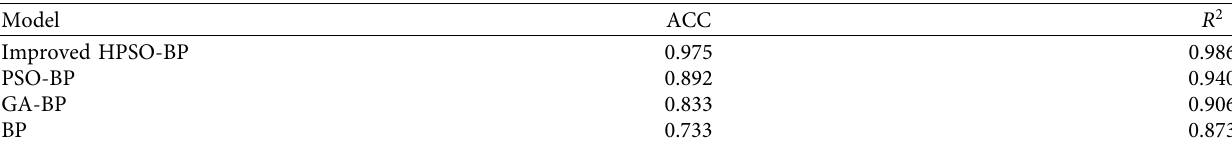
Figure 8: Comparison of prediction results obtained by various models of the airborne-phased array radar. (a) Improved HPSO-BP; (b) PSO-BP; (c) GA-BP; (d) BP. Table 4: Comparison of evaluation indices of various models of the airborne-phased array